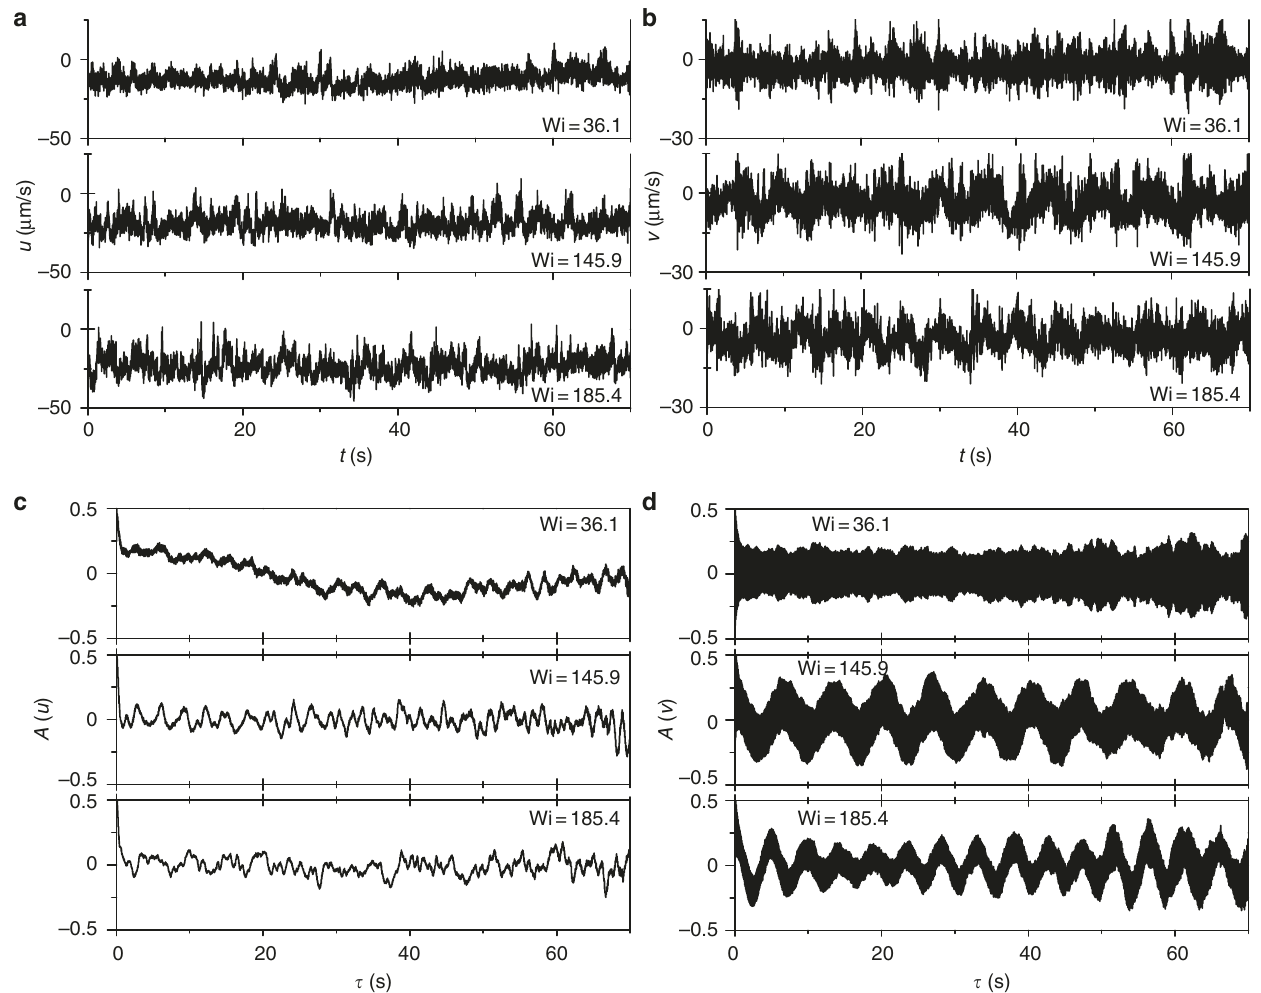
Fig. 2 Streamwise and cross-stream components of velocity and corresponding autocorrelation functions. Time series of a streamwise velocity u and b cross-stream velocity v , obtained at ( x / R , y / R ) = (2.3, 0.03), corresponding to the location near the line connecting the centers ’ of obstacles and close to the center region between the obstacles, for three values of Wi. c , d Their respective temporal autocorrelation functions A ( u ) and A ( v